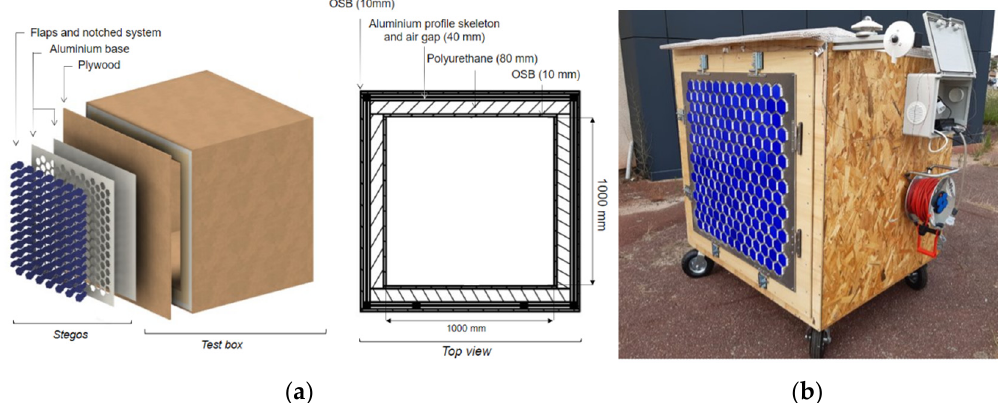
Figure 6. ( a ) Diagram of the tests box with the Stegos as an opaque wall. ( b ) Photograph of the test box with the Stegos integrated on one of the façades.